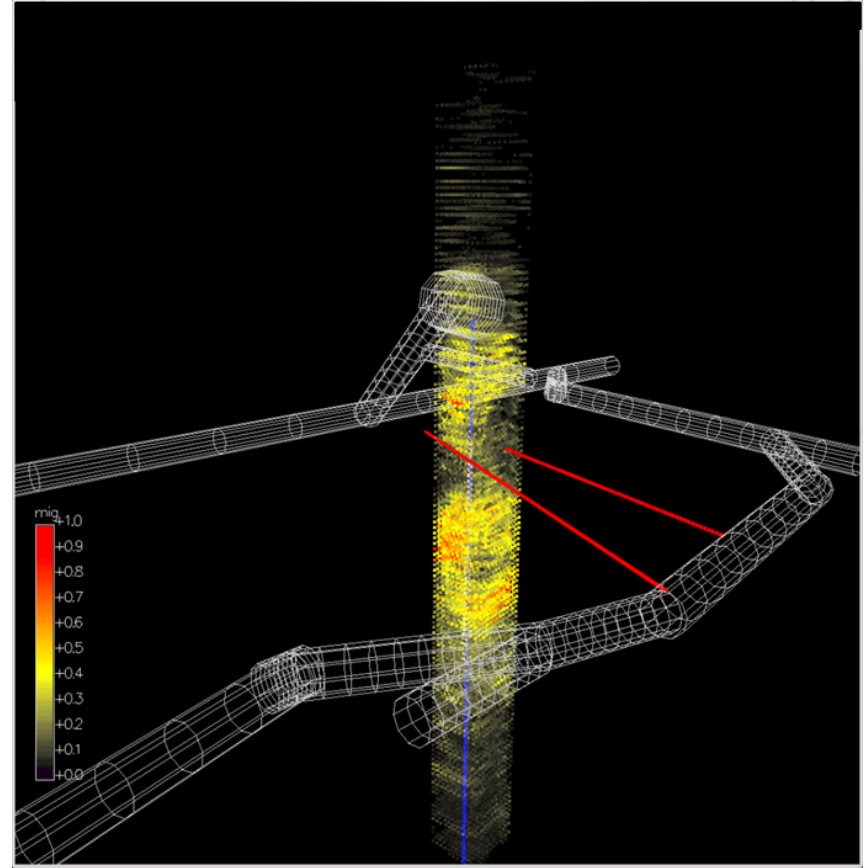
Figure 3: Example of a Fresnel-Volume-Migration for shear waves to image the surrounding area of the vertical borehole BH 3. High reflective areas caused by fracture zones are marked by yellowish and reddish